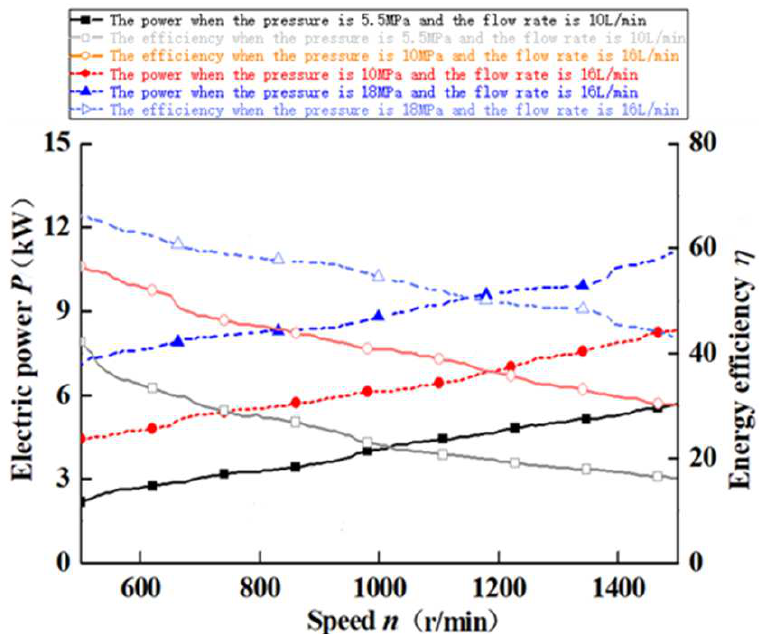
Figure 17. Variable-speed and -displacement compound motor input power.